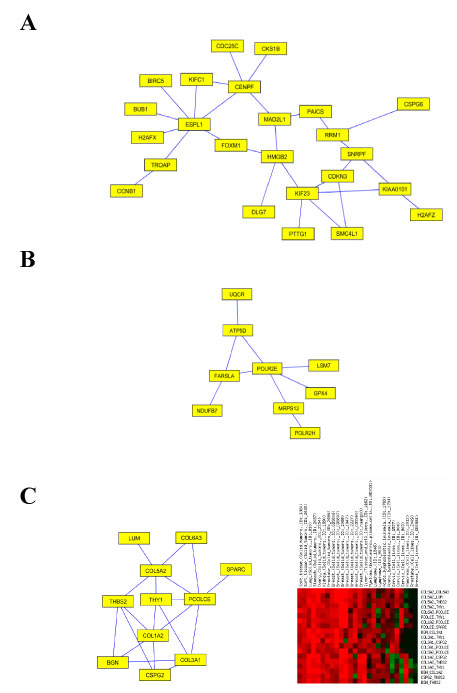
General cancer and solid tumor network modules. (A) A network module that tend to activate in most of cancer datasets, consisting 24 genes and 28 edges. Average correlation across all data sets is 0.42. Most of genes in the module are related to cell division and genetic stability.(B) Another network module that is activated in most of cancer datasets, consisting 9 genes and 9 edges. The module is located in the same second order cluster as the one in figure 2a. Its average correlation across all datasets is 0.39. Most of genes in the module are related to nucleobase, nucleoside, nucleotide and nucleic acid metabolism.(C) Left : a network that tends to be activated only in solid tumor datasets. Right, the co-expression heatmap of the edges across datasets. Six datasets are not shown in the heatmap due to lack of valid co-expression estimations. Average correlation in solid tumor datasets and other datasets are 0.61 and 0.17, respectively.